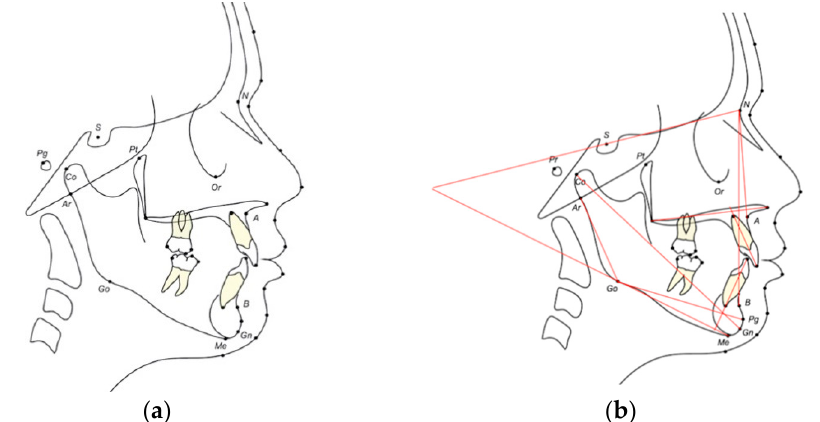
Figure 4. ( a ) Reference points for the cephalometric analysis; ( b ) Angular and linear measurements in the cephalometric analysis.